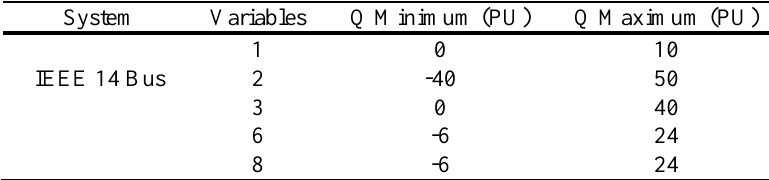
Table 2. Constrains of reactive power generators.